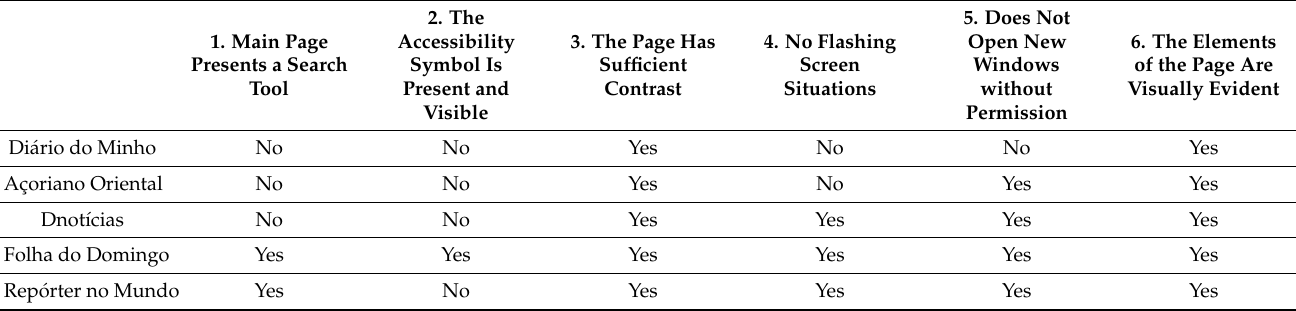
Table 3. Results of the evaluation of the design of Portuguese